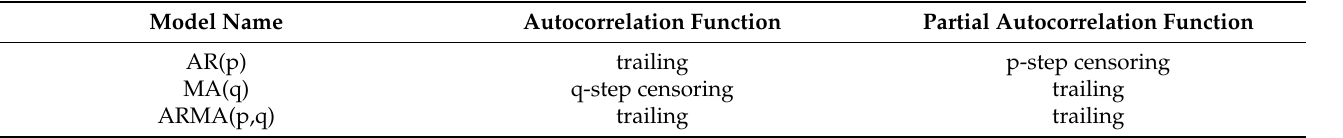
Table 2. Time Series Model